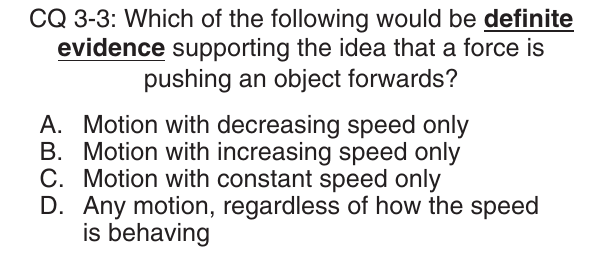
FIG. 14. Fourth clicker question in U2L03.